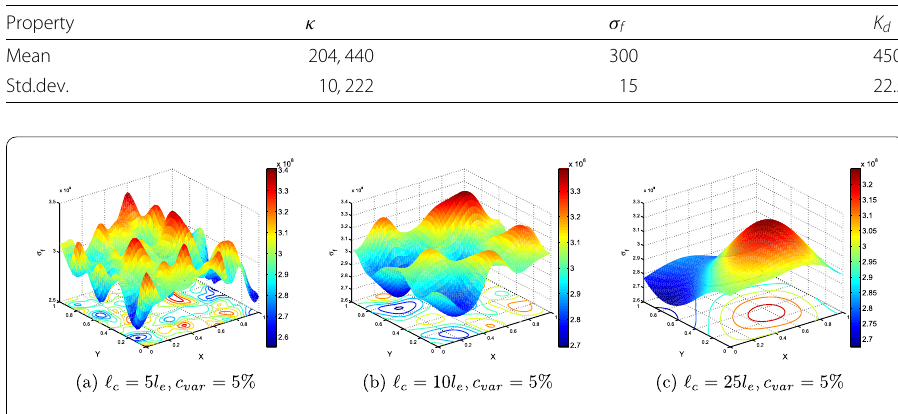
using different values of the correlation length (cid:23) c ∈ { 5 l e , 10 l e , 25 l e } ( l e is the element length on the meso-scale) and coefficients of variation c var ∈ { 5% , 10% }